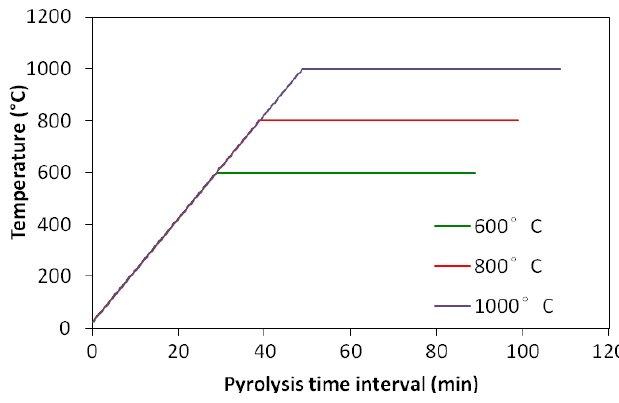
Figure 2. Char pyrolysis time interval at 600, 800 and 1000 °C.